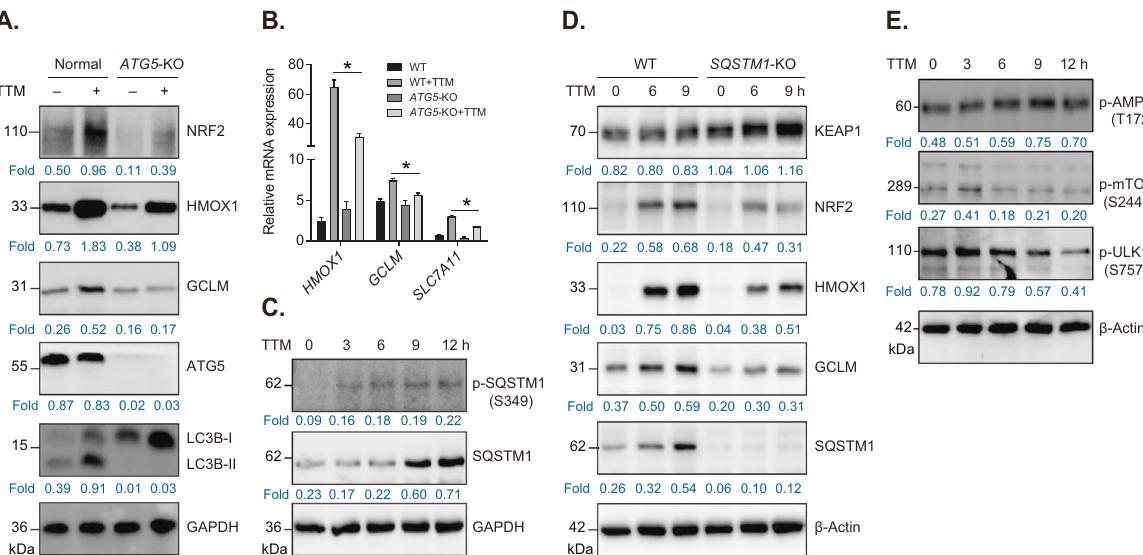
Fig. 4 Autophagy contributes to NRF2 pathway activation in TTM-treated HUVECs. A Western blot analysis and quanti fi cation of NRF2, HMOX1, GCLM, ATG5, and LC3B in WT or ATG5 -KO cells treated with or without 100 μ M TTM for 12 h. GAPDH was used as loading control. B qPCR analysis for HMOX1 , GCLM , and SLC7A11 in WT and ATG5 -KO cells after treatment with or without TTM. One-way ANOVA followed by a Tukey multiple comparison test was used for statistical analysis. * p < 0.05. C Western blot analysis and quanti fi cation of p-SQSTM1 (S349) and SQSTM1 in HUVECs treated with 100 μ M TTM for indicated time. β -Actin was used as loading control. D Western blot analysis and quanti fi cation of KEAP1, NRF2, HMOX1, GCLM, and SQSTM1 in WT and SQSTM1 -KO cells treated with TTM for indicated time. β -Actin was used as loading control. E Western blot analysis and quanti fi cation of p-AMPK α (T172), p-MTOR (S2488), and p-ULK1 (S757) in TTM-treated HUVECs. β -Actin was used as loading